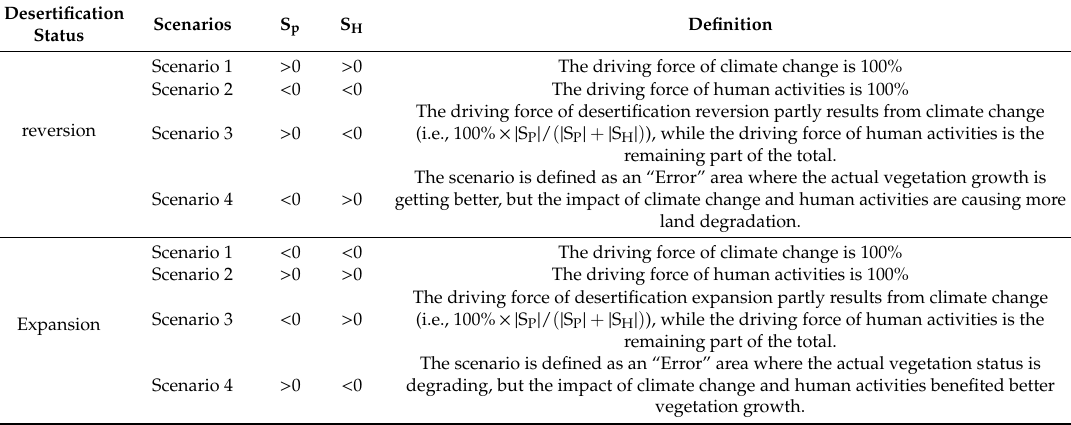
Table 5. Eight scenarios of the impact of climate change and human activities on desertification. Desertification Status